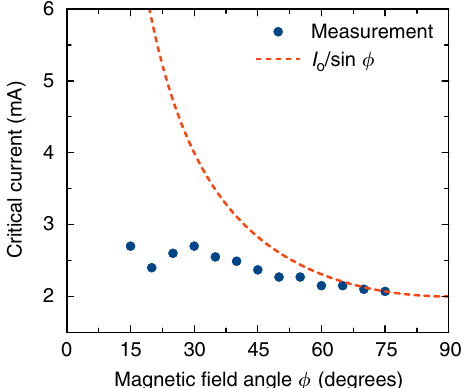
Fig. 3 Angular dependence of the critical current. Critical current for the onset of auto-oscillations as a function of in-plane magnetic fi eld direction ϕ . The line shows the expected behavior due to only a spin Hall current (with a fi tting parameter I 0 ) in the absence of a spin Seebeck